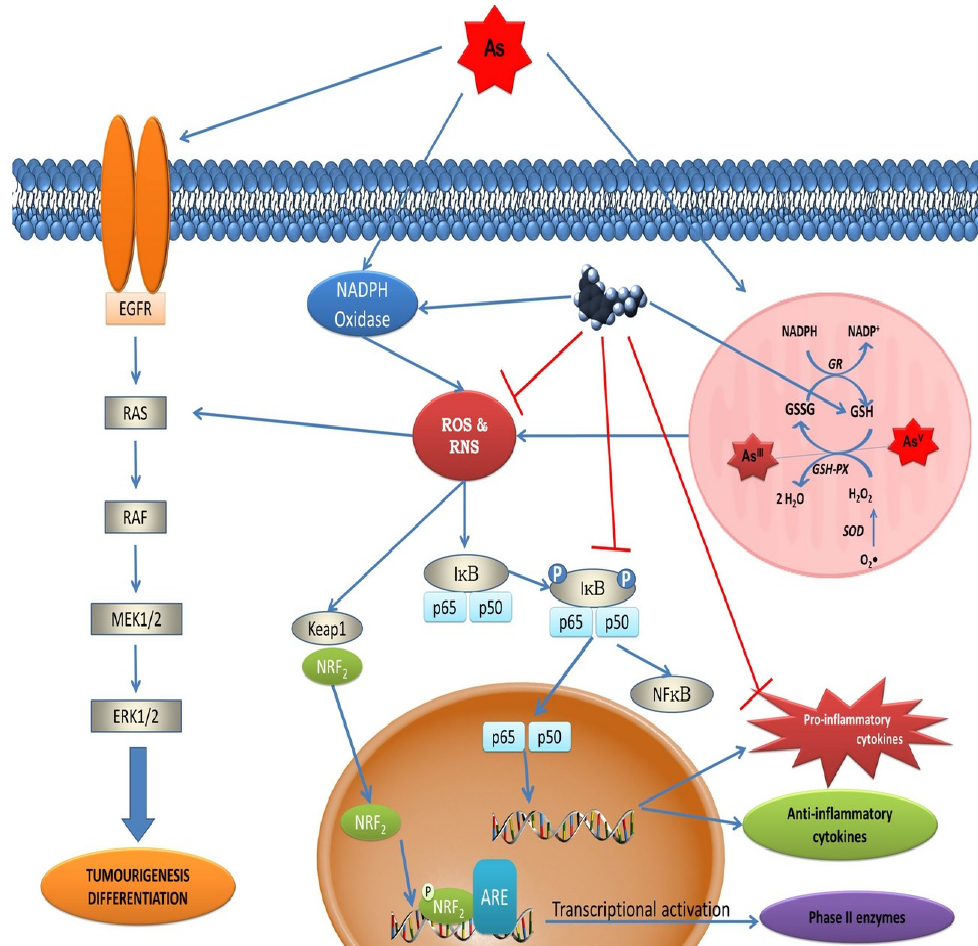
Figure 3. Arsenic-induced tumorigenesis and cell differentiation involve epidermal growth factor receptor (EGFR) signaling via MAP kinases. ROS generated after exposure to arsenic also activates molecules such as Ras and ERK and the I κ B complex. I κ B complex phosphorylation leads to p65 and p50 translocation into the nucleus, which causes the activation of pro- and anti-inflammatory cytokines. These are important contributors to carcinogenesis. ROS also activate nuclear factor (erythroid-derived 2)-like 2 (Nrf2), a key transcription factor that regulates the cellular redox re- sponse. The oxidation of As 3+ to As 5+ under physiological conditions leads to the formation of H 2 O 2 . Melatonin counteracts the toxic and tumorigenic effects caused by As by scavenging ROS production and stimulating antioxidative enzymes, increasing GSH levels, and modulating transcription factors such as NF κ B and Nrf2. From Romero et al. [12], with